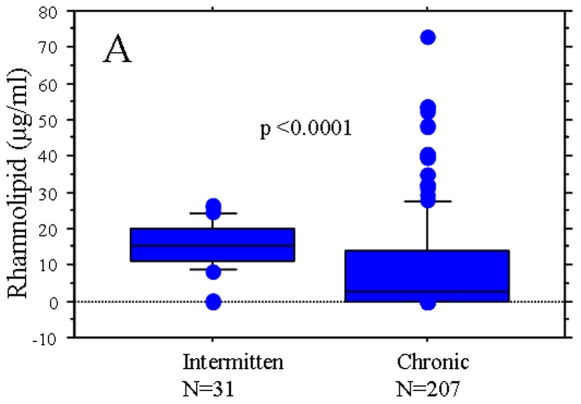
Distribution of in vitro rhamnolipid production in P. aeruginosa isolates from CF patients at different stages of lung infection.The box and whisker plots represent the median (thick line inside the box), 10, 25, 75 and 90 centiles of the in vitro rhamnolipid production (µg/ml) of P. aeruginosa isolates from intermittently colonized and chronically infected patients; Mann-Whitney test was used to investigate the significance of the difference between the groups.